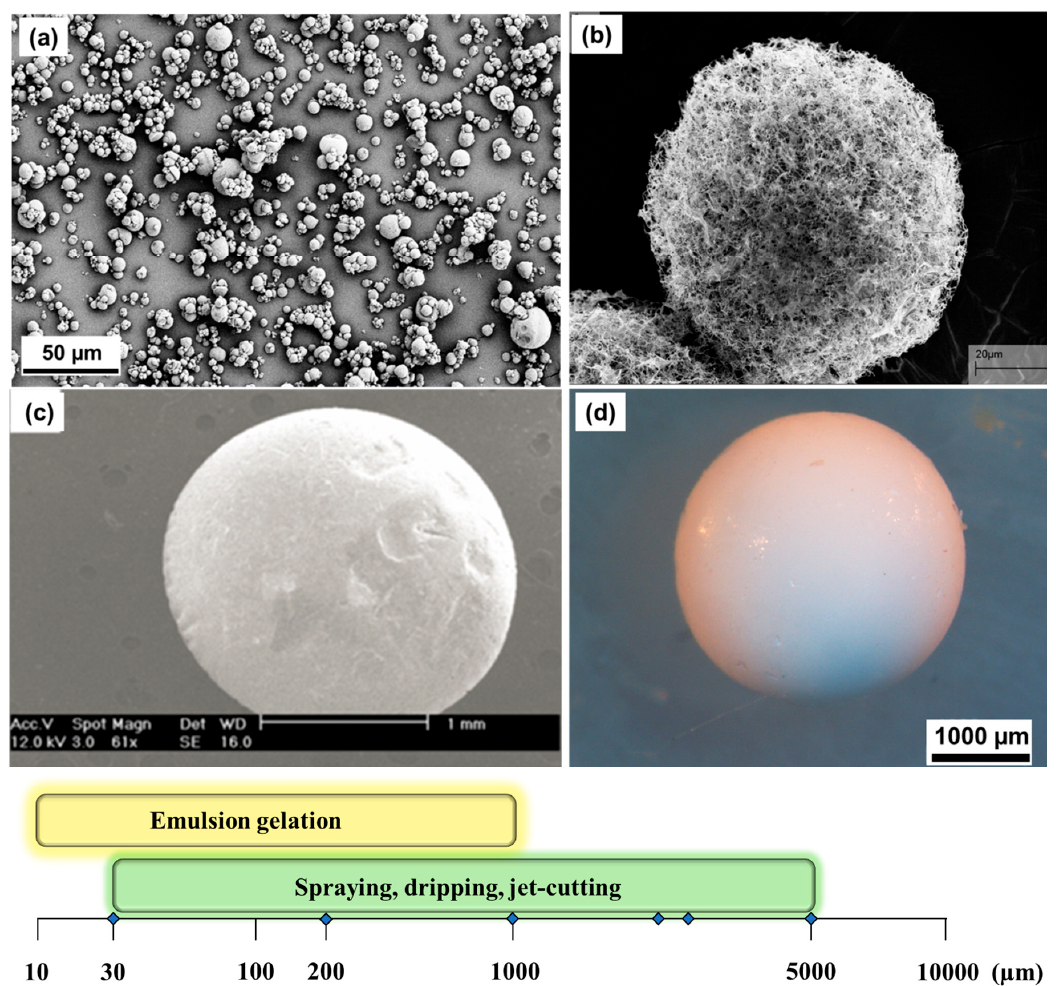
Figure 14. Comparison of aerogel particles prepared by different techniques. Scanning electron microscopy images of particles prepared by emulsion ( a ), spraying, image reproduced with permission from [94] ( b ), jet-cutting (JetCutter), image reproduced with permission from [151] ( c ) and light microscopy image of aerogel particles by syringe dropping method ( d ). Sketch at the bottom showing the range of particle sizes prepared by employing suitable preparation methods.